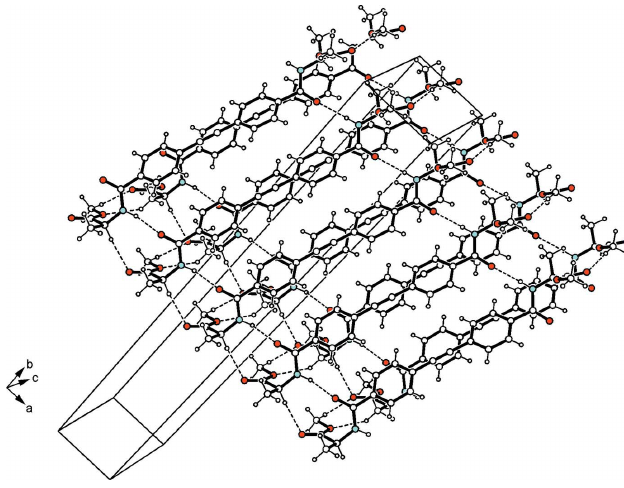
(30), R 2 (10)] are 2 2